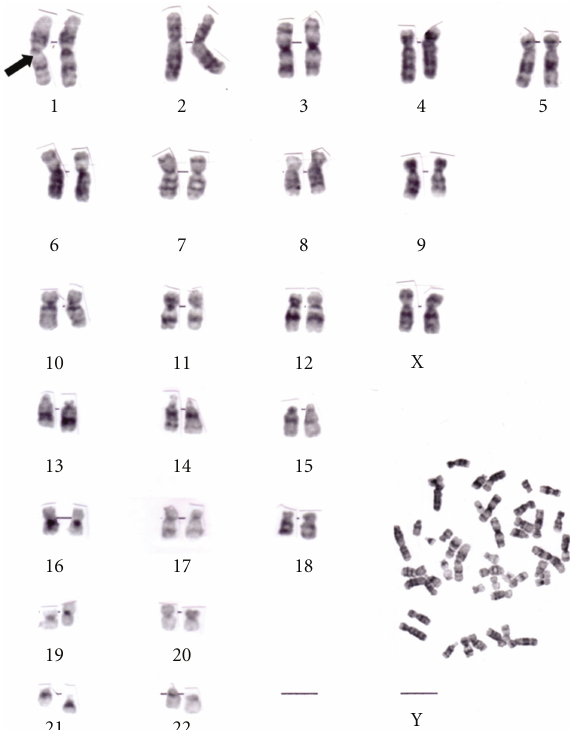
Figure 1: Decrease of the heterochromatin on the long arm of chromosome 1 (46, XX,